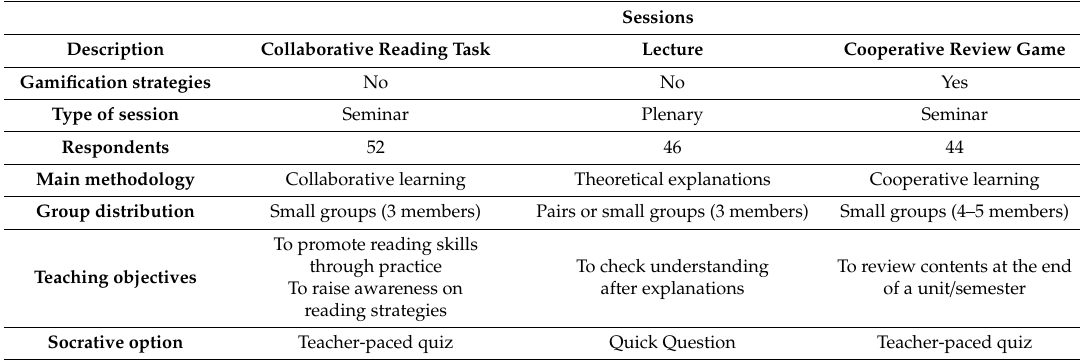
Table 1. Main features of the three Socrative